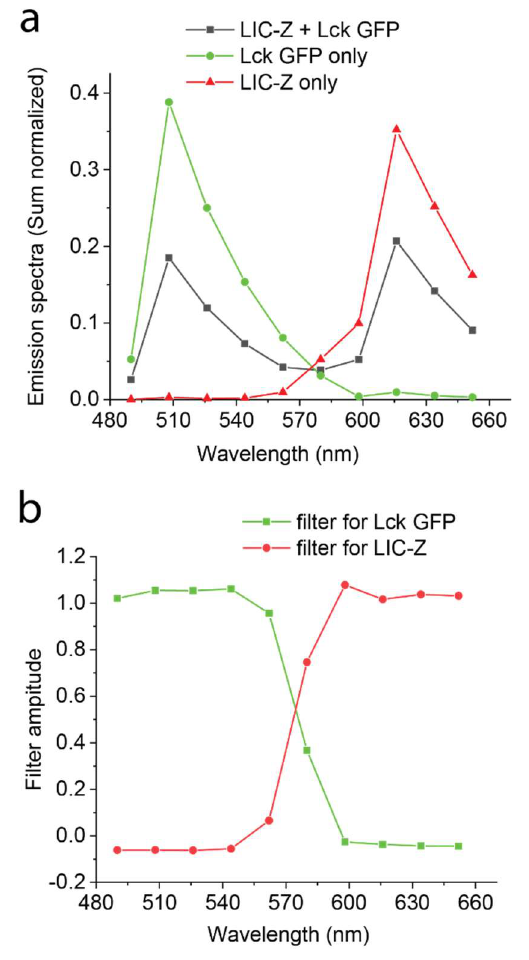
Figure A2. Calculated spectral filter for Lck GFP and LIC-Z in Line-scanning FSCS. ( a ) Emission spectra of Lck GFP (green) and LIC-Z (red) in transfected COS-7 cells were excited simultaneously by 488 nm and 594 nm lasers, which resulted in a mixed sample spectra (black). The fluorescent signal was collected by the GaAsP detector on the Zeiss 880 Laser scanning confocal microscope set at 10 channel mode with 17.8 nm per channel width. ( b) , the calculated spectral filter for Lck GFP (green) and LIC-Z (red) was used to extract photons of respective species in the correlation analysis.